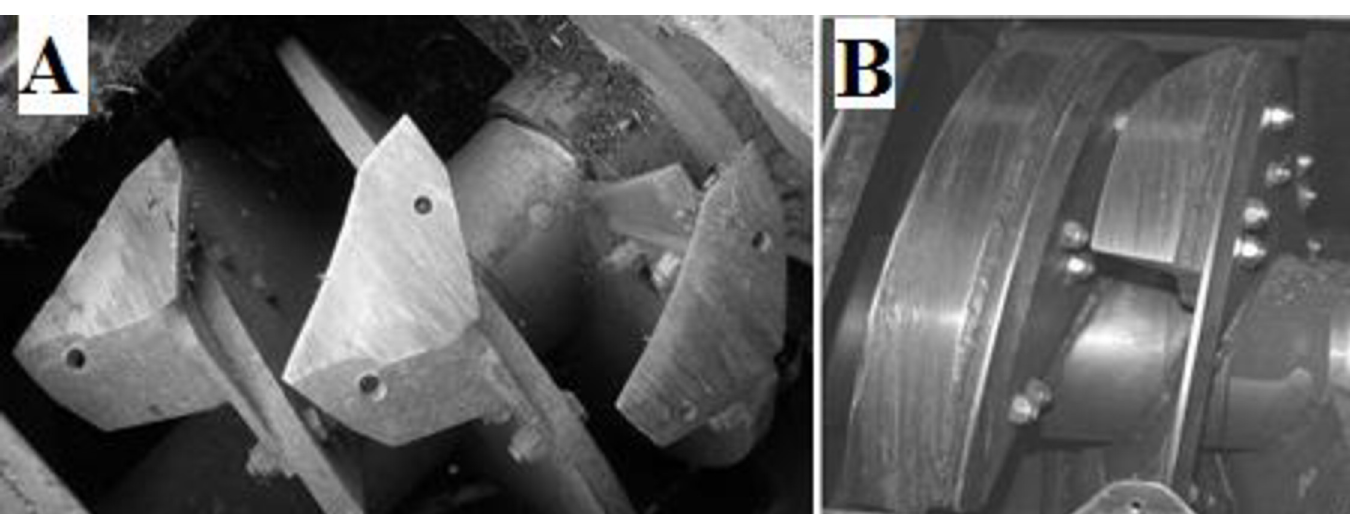
PLOS ONE | https://doi.org/10.1371/journal.pone.0261810 December31,